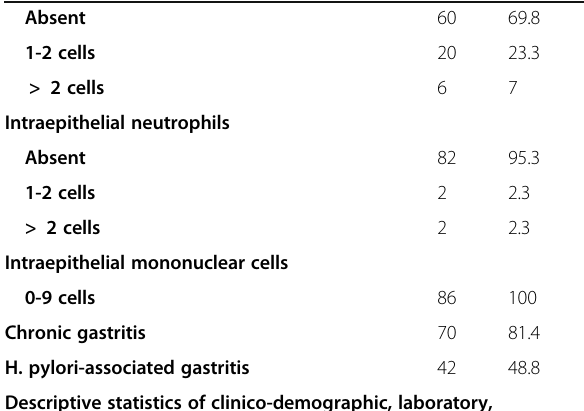
Table 1 Descriptive statistics of demographic, clinical, endoscopic and histopathological parameters of the studied